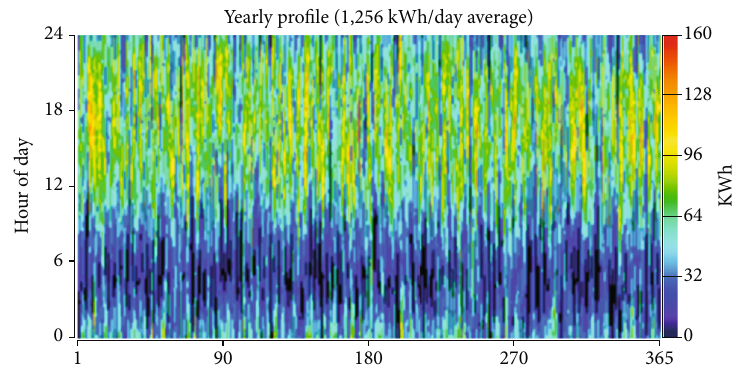
Figure 7: Annual load pro fi le for the managed EV (average of 1258 kWh/day).